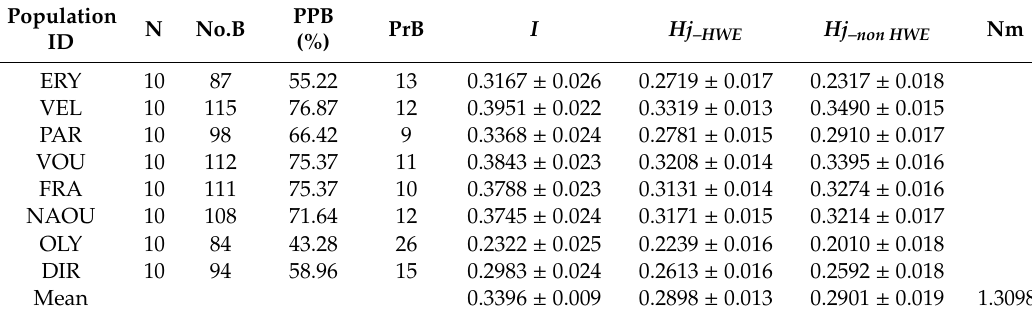
Table 3. Genetic diversity as detected by ISSR markers; N = numbers of individuals surveyed from each population; No. B = number of scored bands PPB = Percentage of Polymorphic Bands; PrB = private bands; I = Shannon’s Information index; Hj = Nei’s gene diversity after Lynch and Milligan (1994) assuming Hw equilibrium ( Hj –HWE ) or complete shortage of heterozygotes ( Hj –non HWE ); Nm = estimate of gene flow among populations.